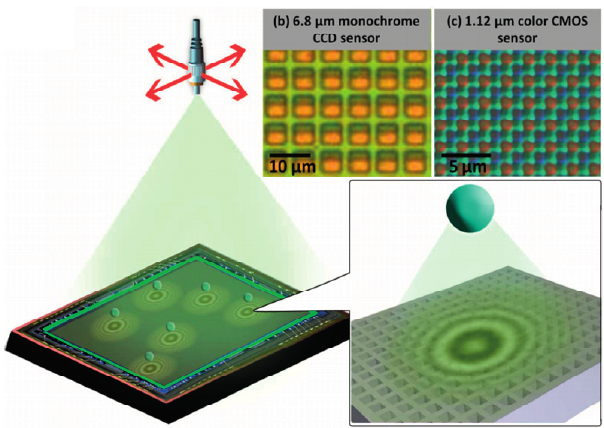
Figure 17. Lensfree on-chip microscopy setup. ( a ) Schematic of the lensfree holographic microscopy setup. The close-up of (a) shows that the scattered wave from the object interferes with the unperturbed reference wave and forms an in-line hologram, which is then sampled by the image sensor chip. The pixel structures exhibit large variability in terms of pixel pitch and morphology as can be seen in (b) and (c). ( b ) Shows an optical microscope image (20× objective, NA = 0.5) of a 6.8 mm monochrome CCD image sensor chip. ( c ) Shows an optical microscope image (100× Water immersion objective, NA = 1) of a 1.12 µm color CMOS image sensor chip, where the Bayer pattern can be readily seen (Reproduced with permission from